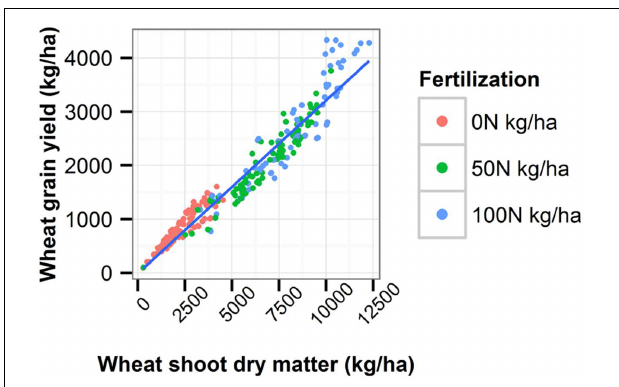
FIGURE 4 | Relationship between wheat grain yield and wheat shoot dry matter. The blue line is the linear regression line, the slope of which defines the harvest index across all treatments. Data is from the Agricultural Production Systems sIMulator simulation combining Wubin climate and soil, conventional tillage and stubble burning. Simulated period: